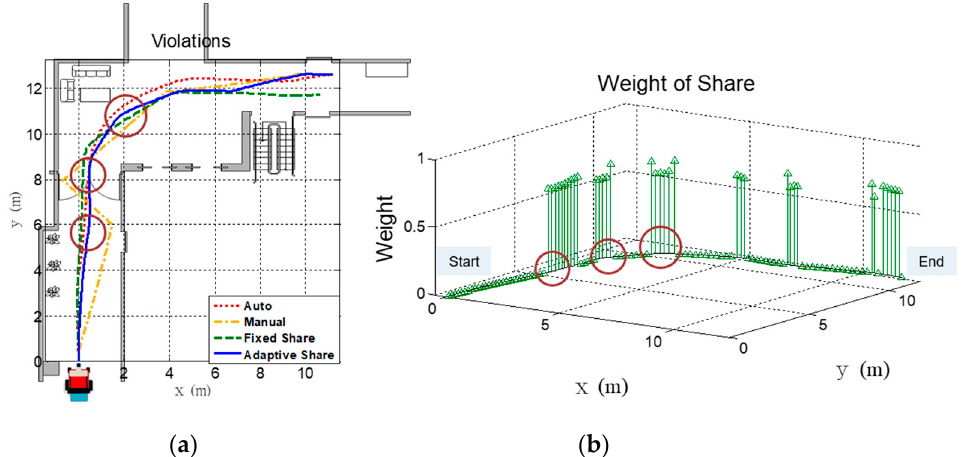
Figure 13. Experimental results of over-speeding operation. ( a ) The trajectories of the four control modes. ( b ) Changes in the weights of adaptive shared control.